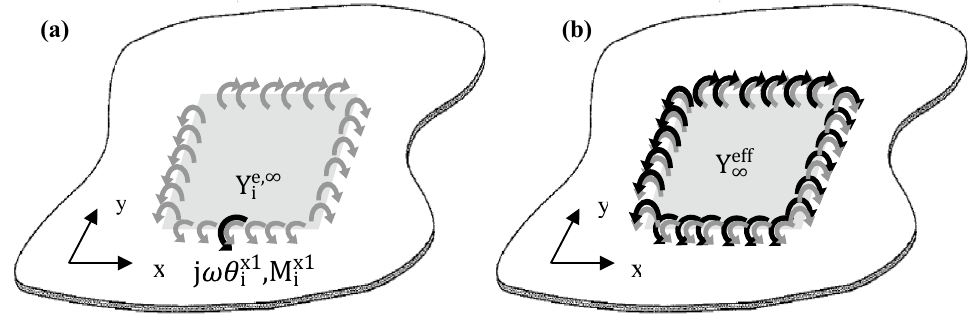
Figure 5. Illustration of ( a ) effective point moment mobility at one point on line x 1 and ( b ) effective line moment mobility of the infinite thin plate 7 .